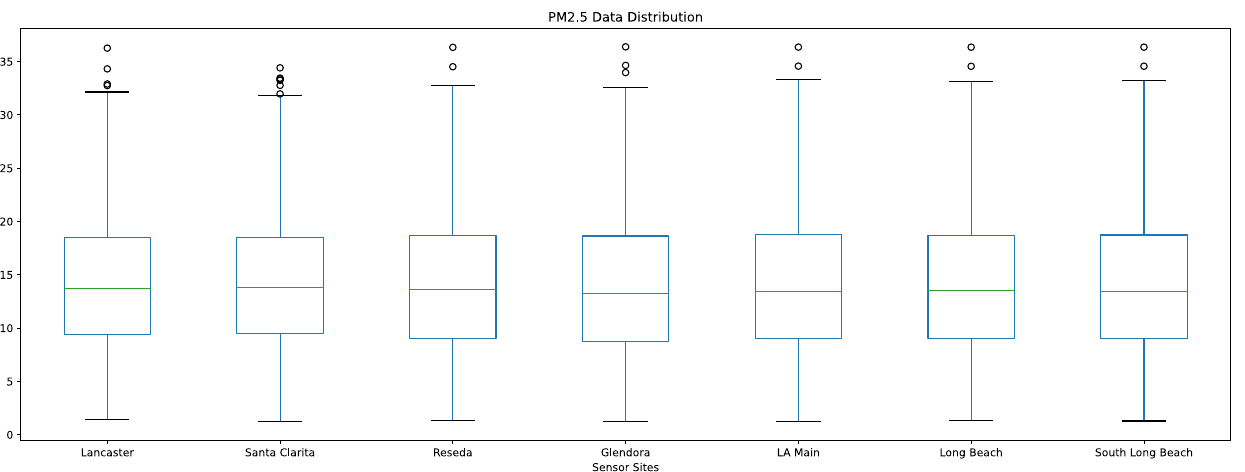
To measure the accuracy of our model, we use the Root Mean Square Error (RMSE) and Normalized Root Mean Square Error (NRMSE) error. RMSE and NRMSE is calculated as RMSE = where n is the number of observations, ˆ y is the predicted value, y is the ground truth, and ¯ y is the mean of the test